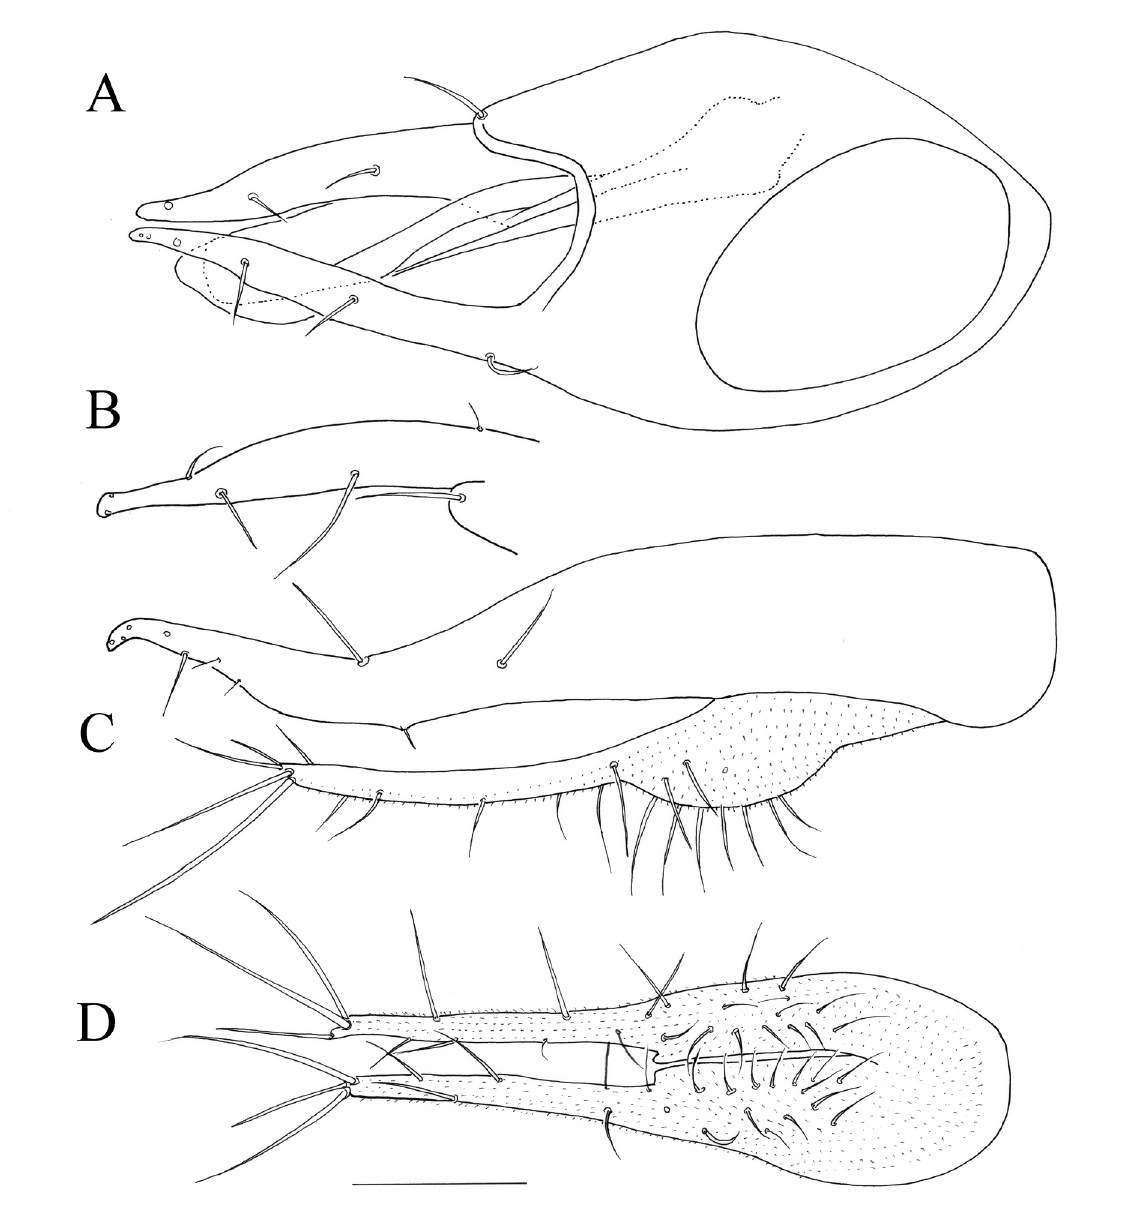
Fig. 4. Thinophilus inaequalis Samoh & Grootaert sp. nov. Male terminalia (Abdulloh Samoh leg., PSUNHM (PSUZCDIP0011)). A . Ventral view on epandrium. B . Tip of right surstylus. C . Lateral view on left side of epandrium with a pointed left surstylus. D . Dorsal view on cerci. Scale = 0.1